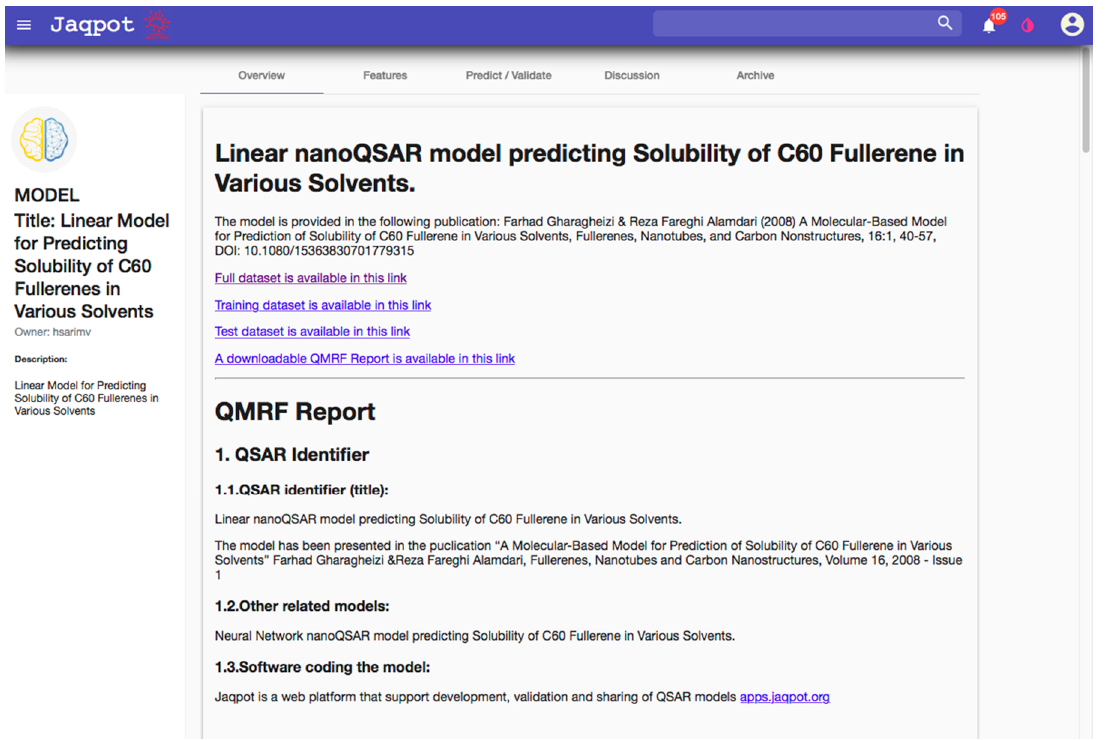
Figure 6. Metadata report (QMRF) of a QSAR model in Jaqpot 5 (NanoCommons platform).